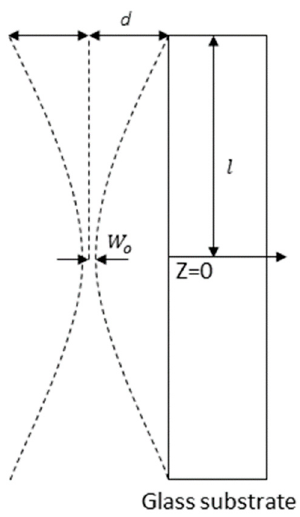
Figure 2. Focused laser beam propagation in the upper glass substrate.